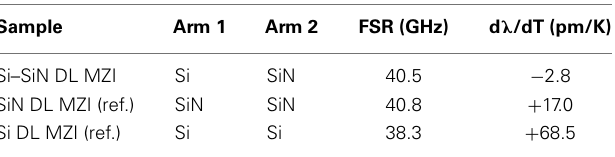
Table 1 | Measured FSRs and d λ /dT .